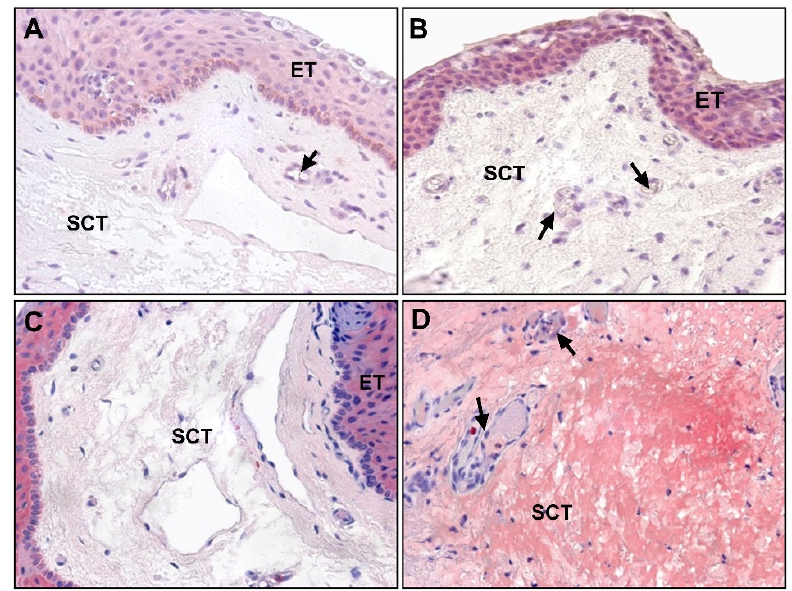
Figure 10. Fibulin-4 expression in ( A ) conjunctival and ( B ) pterygium samples ( × 400). Immunohistochemical staining of fibulin-5 expression in ( C ) conjunctival and ( D ) pterygium tissue ( × 400). Fibulin-4 expression was similar between the healthy and pathological groups. In contrast, increased expression of fibulin-5 was localized in the pterygium subepithelial connective tissue. (ET, epithelial tissue; SCT, subepithelial connective tissue; → , blood vessels).